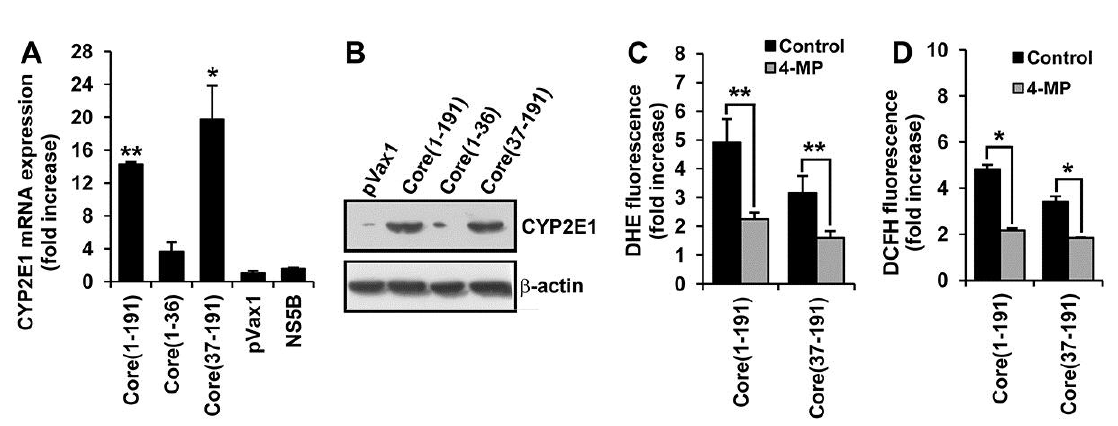
Figure 4. Fragment encompassing aa residues 37–191 of HCV core contributes to ROS production by activating the expression of cytochrome P450 2E1 (CYP2E1). ( A , B ) Up-regulation of CYP2E1 expression in Huh7 cells transfected with plasmids expressing core(1–191) and core(37–191) but not core(1–36) or NS5B protein control assessed by the real-time-qPCR ( A ) and Western blotting ( B ); The levels of CYP2E1 mRNA assessed by